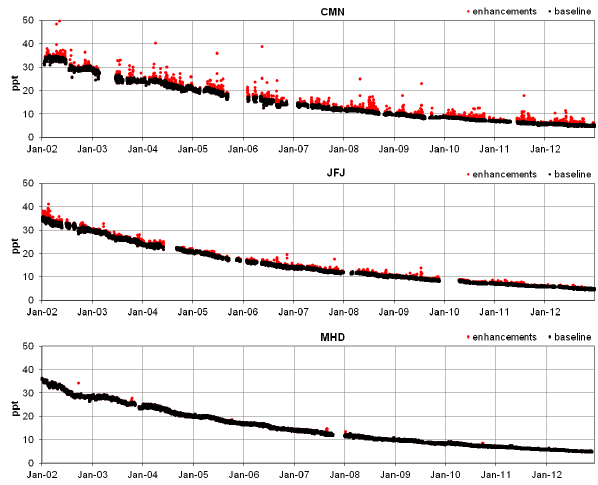
Figure 2. 2002–2013 time series of MCF at CMN (top panel) JFJ (middle panel) and MHD (lower panel). Black dots: baseline data; red dots: enhancements above the baseline. Baseline derived through the statistical method as in Giostra et al.